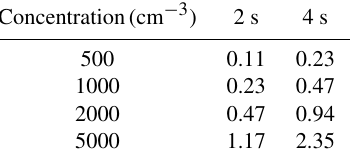
Table 2. Average number of collisions for 800nm particles with a 80µm diameter droplet in a concentration of 1000cm − 3 and resi- dence times of 2 and 4s assuming different values for CE.